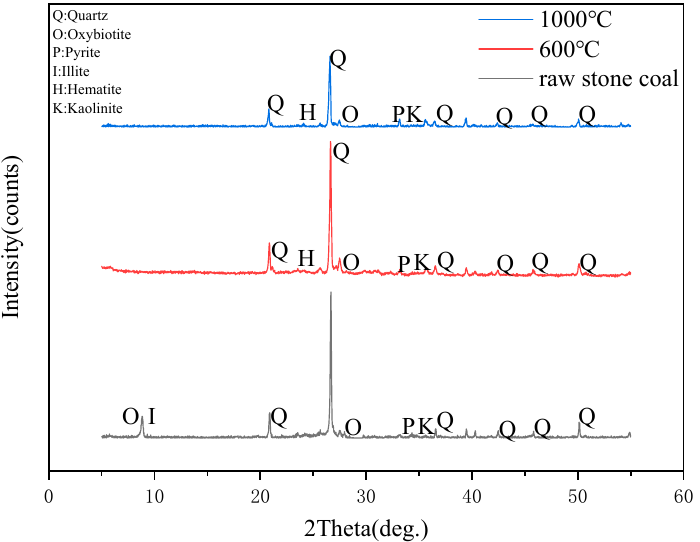
Figure 2. SEM photomicrograph of RC, C6 and C10 produced in the laboratory (tables on the right show the composition of SEM energy spectrum point scanning results, including weight percentage and atomic percentage).